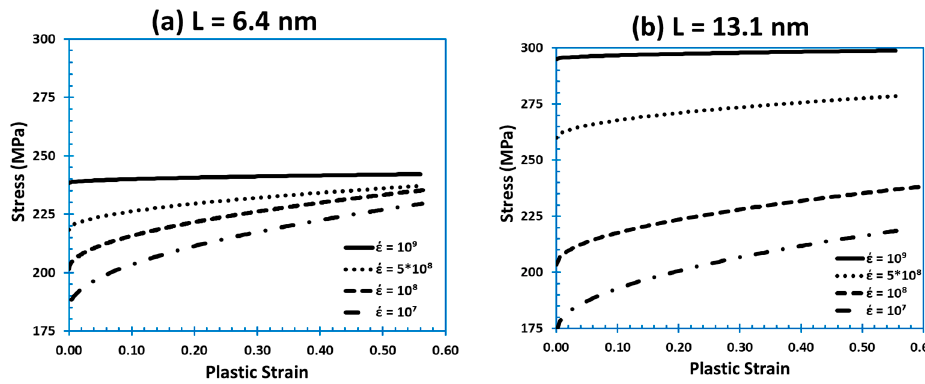
Figure 4. The stress component value corresponding to the VA model contribution of the newly proposed model due to thermal activation processes at 𝜀(cid:4662) = 10 (cid:2875) s (cid:2879)(cid:2869) , 𝜀(cid:4662) = 10 (cid:2876) s (cid:2879)(cid:2869) , 𝜀(cid:4662) = 5 × 10 (cid:2876) s (cid:2879)(cid:2869) , and 𝜀(cid:4662) = 10 (cid:2877) s (cid:2879)(cid:2869) for both sizes simulated in this work .